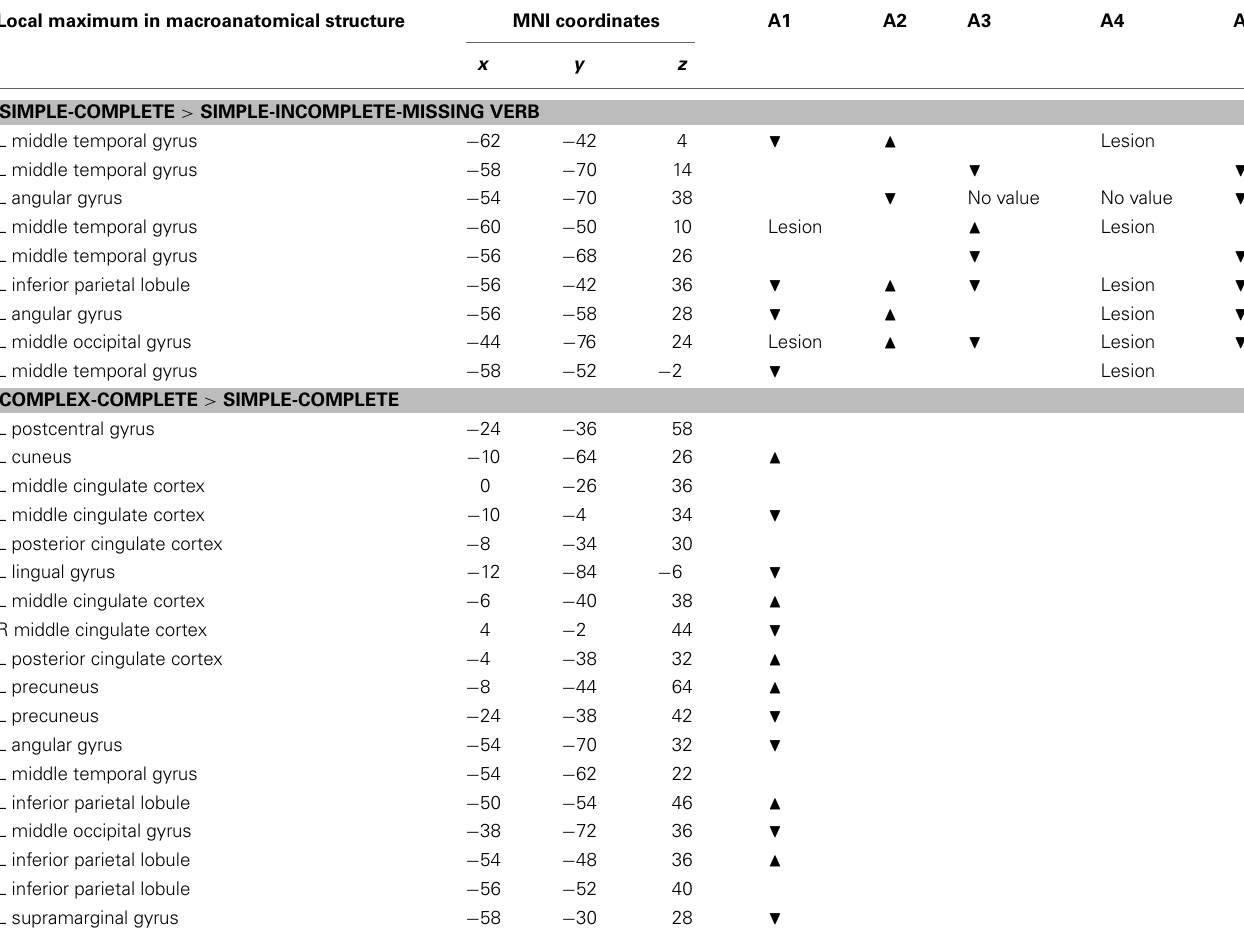
Table 5 | Comparison of aphasic speakers’ spmT-values and the groups’ mean at the coordinates of the healthy speakers’ maxima. Local maximum in macroanatomical structure MNI